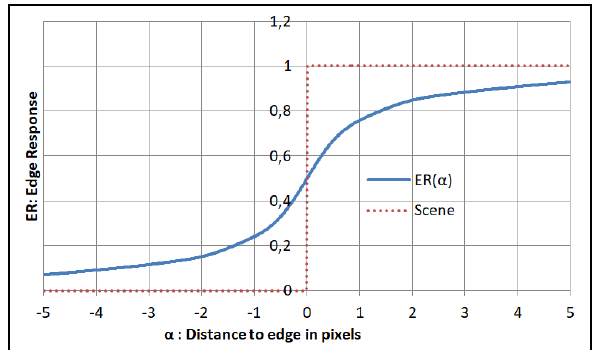
Figure 1. Edge response without MTFC sharpening (G = 1)